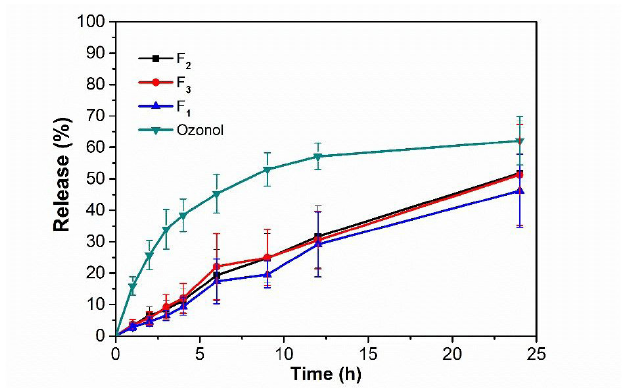
FIGURE 1 - In vitro release profiles of IBU from patch formulations. The results are expressed as mean ± SEM (n=6). * p < 0.05 vs.